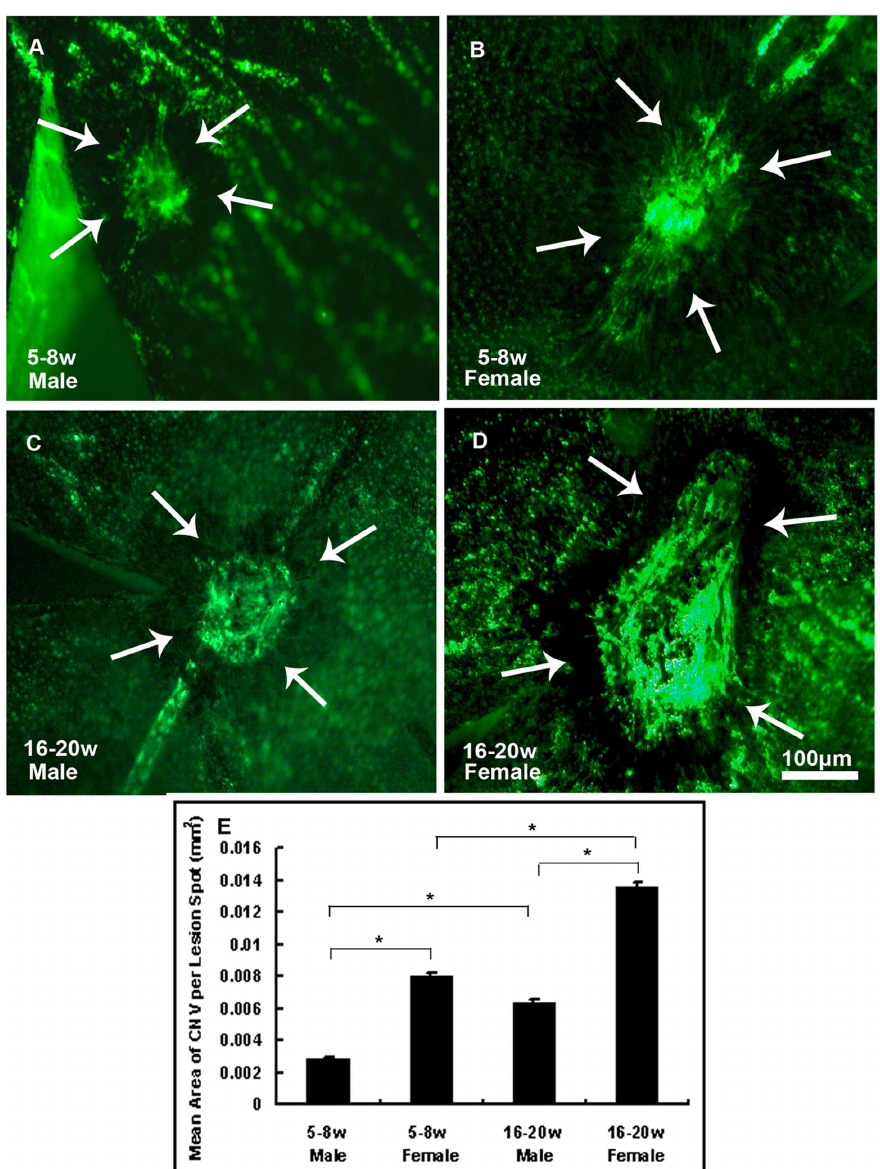
Figure 2. Significantly bigger area of CNV was observed in older female mice. 5–8-week old male (Fig. 2A) or female (Fig. 2B) and 16–20- week old male (Fig. 2C) or female (Fig. 2D) C57BL/6 mice were anesthetized and burns were given at 3, 12 and 9 o’clock positions that were 1PD away from the optic disc in the posterior pole of retinas with a cover slide placed on the cornea as a contact lens. After 2 weeks, mice were perfused with fluorescein-labeled dextran and choroidal flat mounts were examined by fluorescence microscopy. Image analysis software (Image-Pro Plus) was used to measure the total area of CNV at each rupture site and the mean area of CNV per eye was calculated to give a single experimental value. The bars show the mean + 2 SEM for each group calculated from experimental values (Fig. 2E). Statistics were analyzed by two-way ANOVA. (n=6mice/group, *P , 0.001).